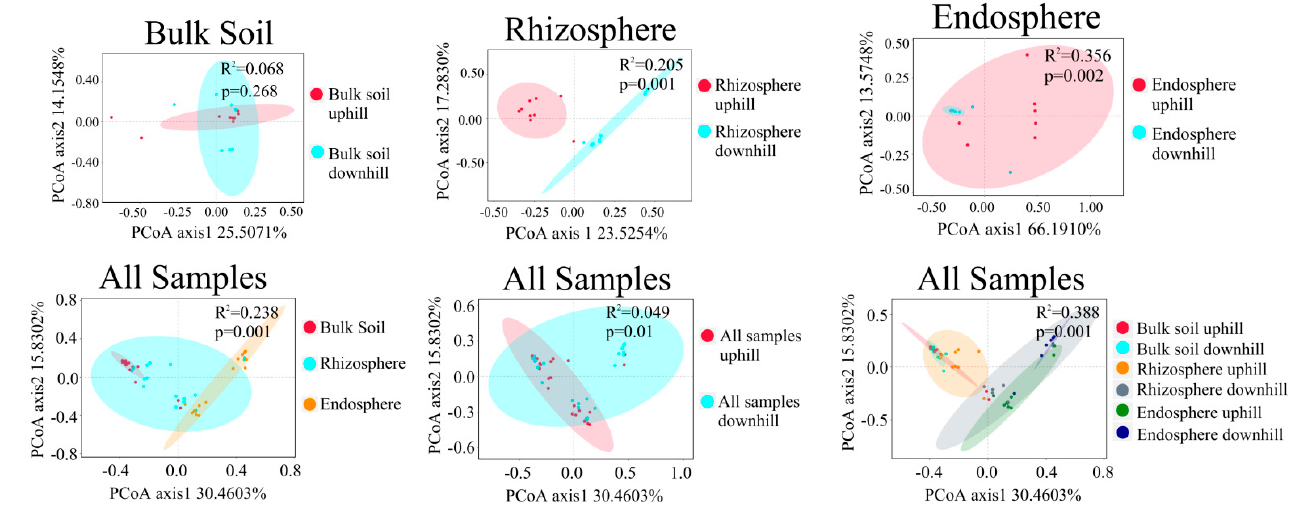
Figure 1. Unconstrained PCoA plot showing the variations in fungal communities based on the Bray–Curtis distance (PERMANOVA tested the significant differences). Ellipses indicate 95% confidence intervals for each sample type.